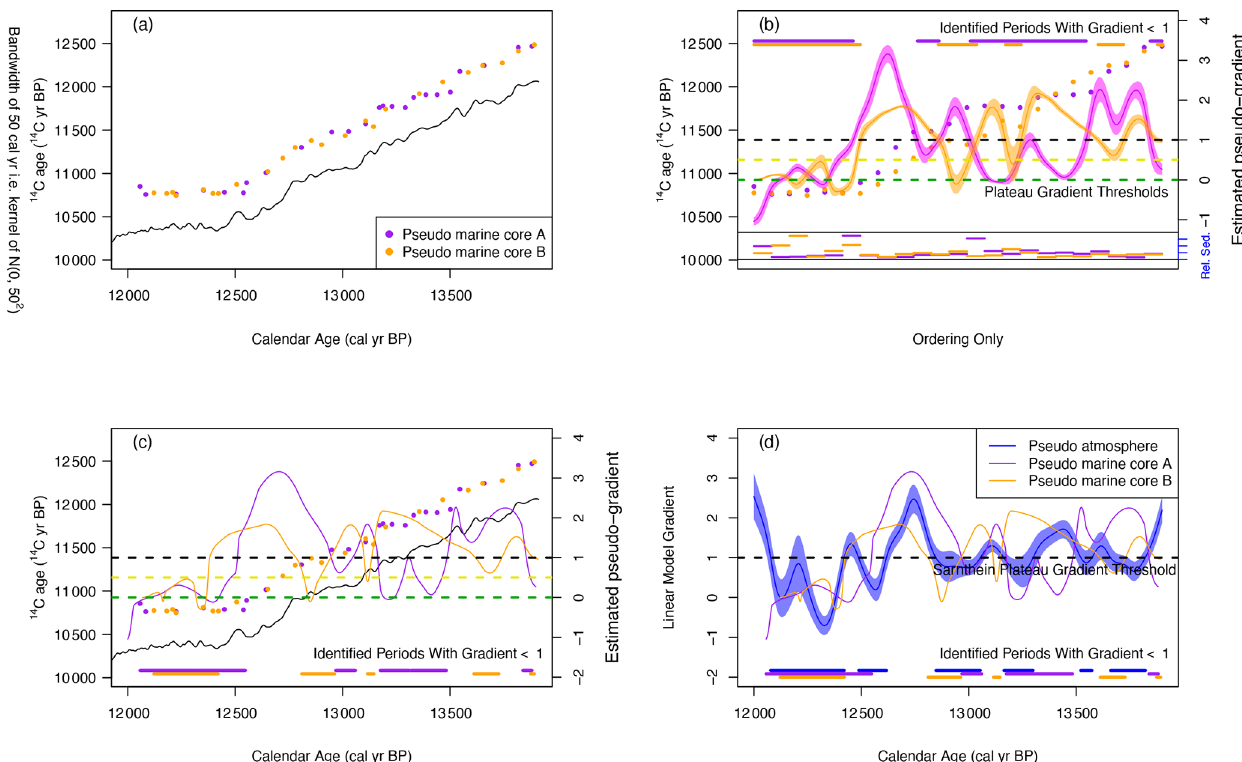
Figure 7. Simulation study to identify the ability to identify 14 C age plateaus in marine records for which calendar age scales are not initially known. In panel (a) , we simulate two marine records between 12–13.9calkyrBP, again using the tree-ring-based IntCal20 mean as the ground truth. These simulated marine cores are based upon the sampling density of the Cariaco Basin un-varved record (Hughen et al., 2006) with a similar level of observational 14 C noise and have been created with a constant MRA of 400 14 Cyr. To identify plateaus, we first estimate the gradient on the basis of an unknown calendar age scale. We create a pseudo-calendar age scale by rescaling the observations so that they are equally spaced along the cores before applying our locally weighted linear model approach, using an equivalent N (0 , 50 2 calyr 2 ) kernel, to estimate the gradients on this (equally spaced) pseudo-scale. Estimates of pseudo-gradients and implied relative sedimentation rates on this equally spaced pseudo-timescale are provided in panel (b) . At the top, we plot (color coded by core) the section of core for which we would obtain a local pseudo-gradient below 1 14 Cyr(pseudo-calyr) − 1 and which could be identified as a 14 C age plateau. Scaling back to the true underlying calendar age timescale, panel (c) indicates where, in terms of the actual calendar age scale, one might classify plateaus. In panel (d) , these are overlain against the first of our simulated atmospheric records in Fig. 5 to assess synchroneity. As a rug we show the time periods, on the true underlying calendar age timescale, corresponding to local gradient threshold estimates below 1 14 Cyr(calyr) − 1 for the simulated atmospheric record and 1 14 Cyr(pseudo-calyr) − 1 for the two simulated marine